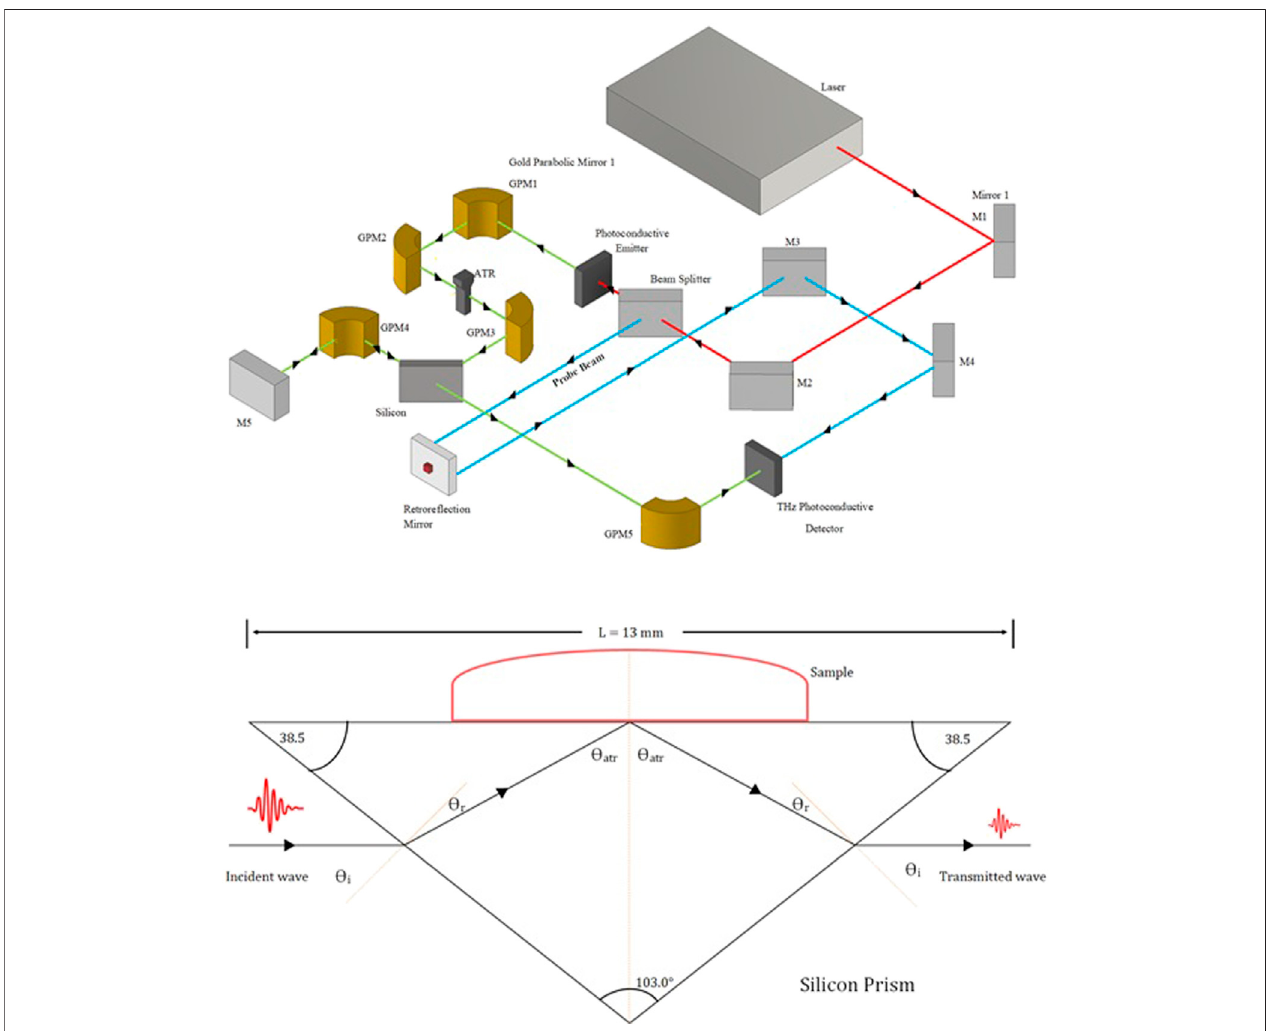
FIGURE 2 | Schematic plot of THz TDS (upper) and ATR module (lower) .